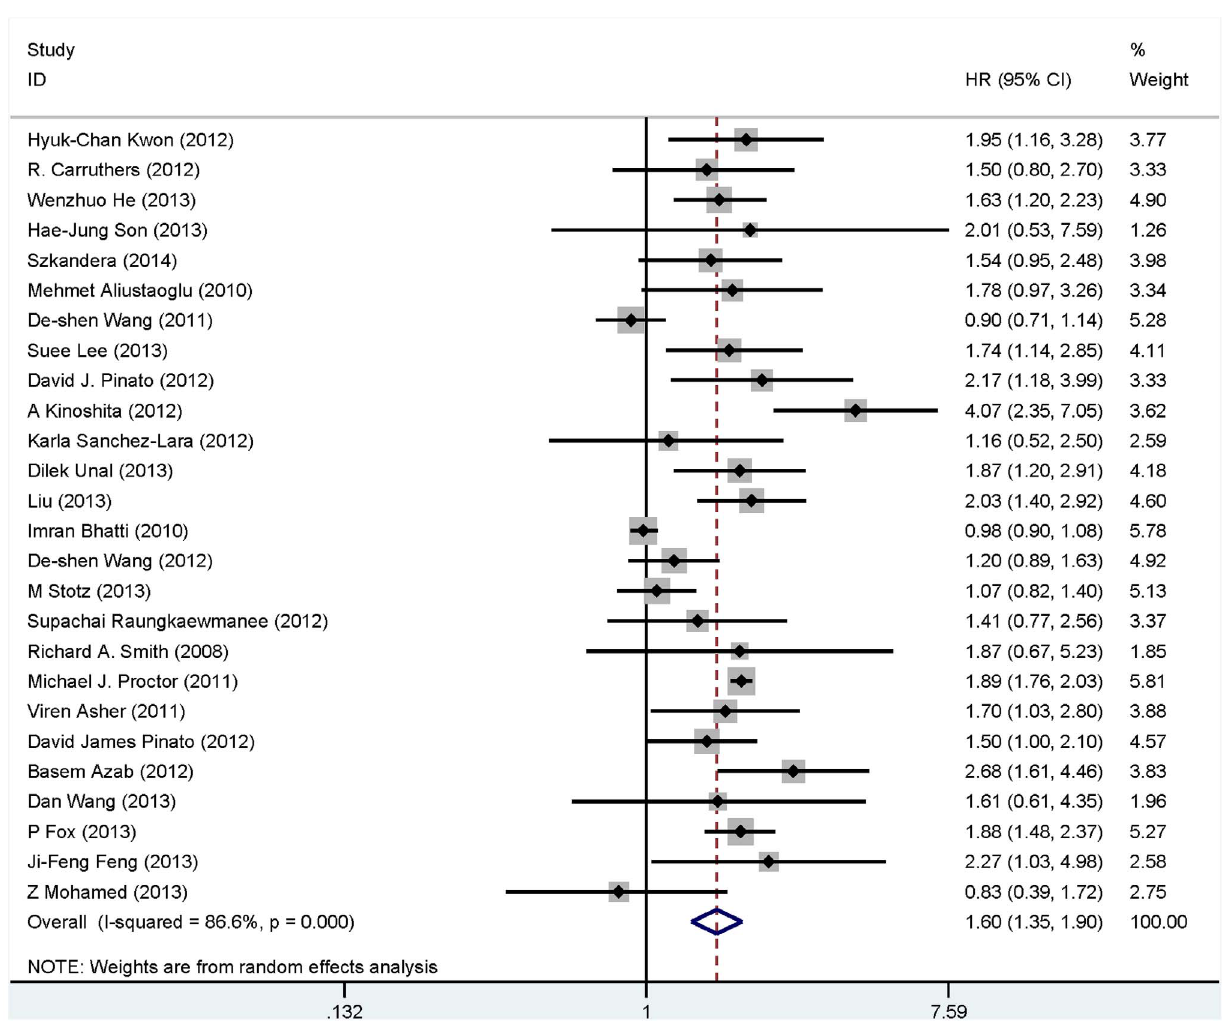
Figure 2. Forrest plots of studies evaluating hazard ratios (HRs) of PLR for overall survival.